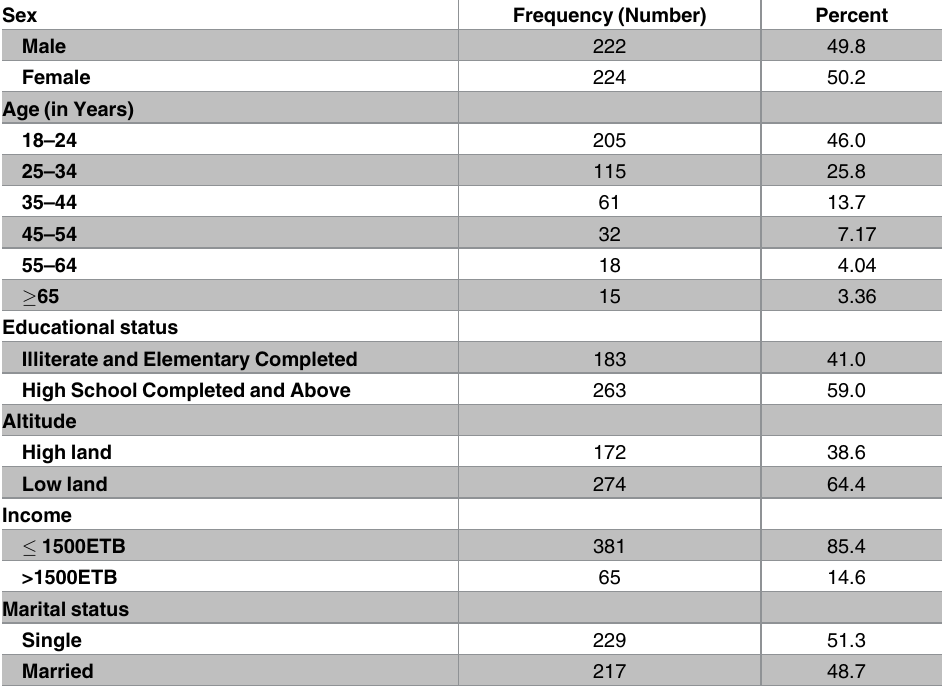
Table 1. Demographic characteristics of study